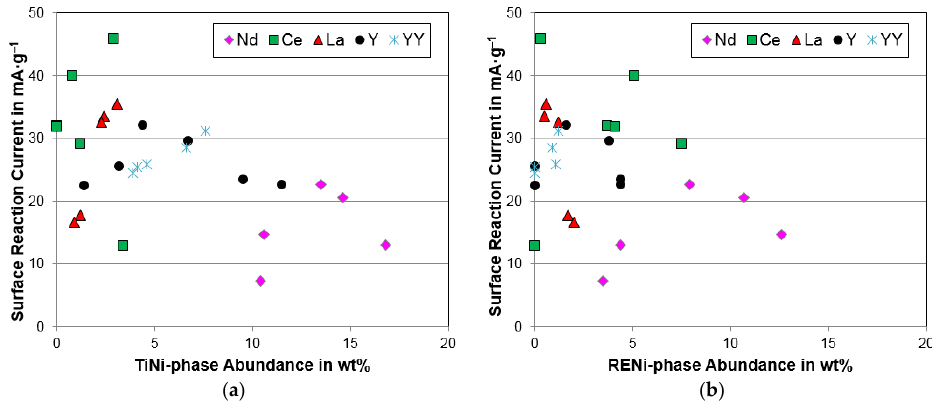
Figure 14. Correlations between diffusion coefficient and ( a ) TiNi phase abundance; and ( b ) RENi phase abundance.